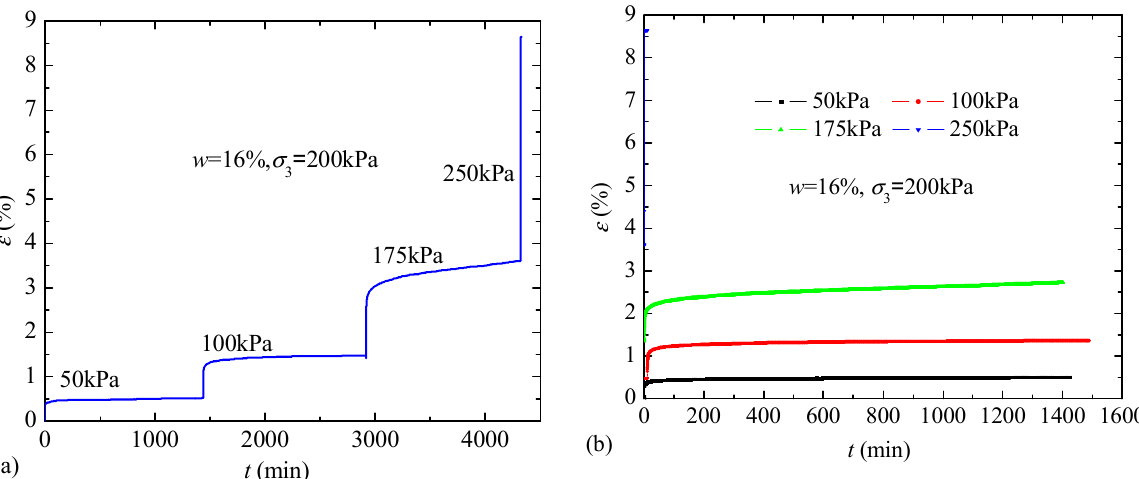
Figure 8. ( a ) The whole process curve of creep for loess with 15 dry-wet cycles, ( b ) creep curves of loess with 15 dry-wet cycles.